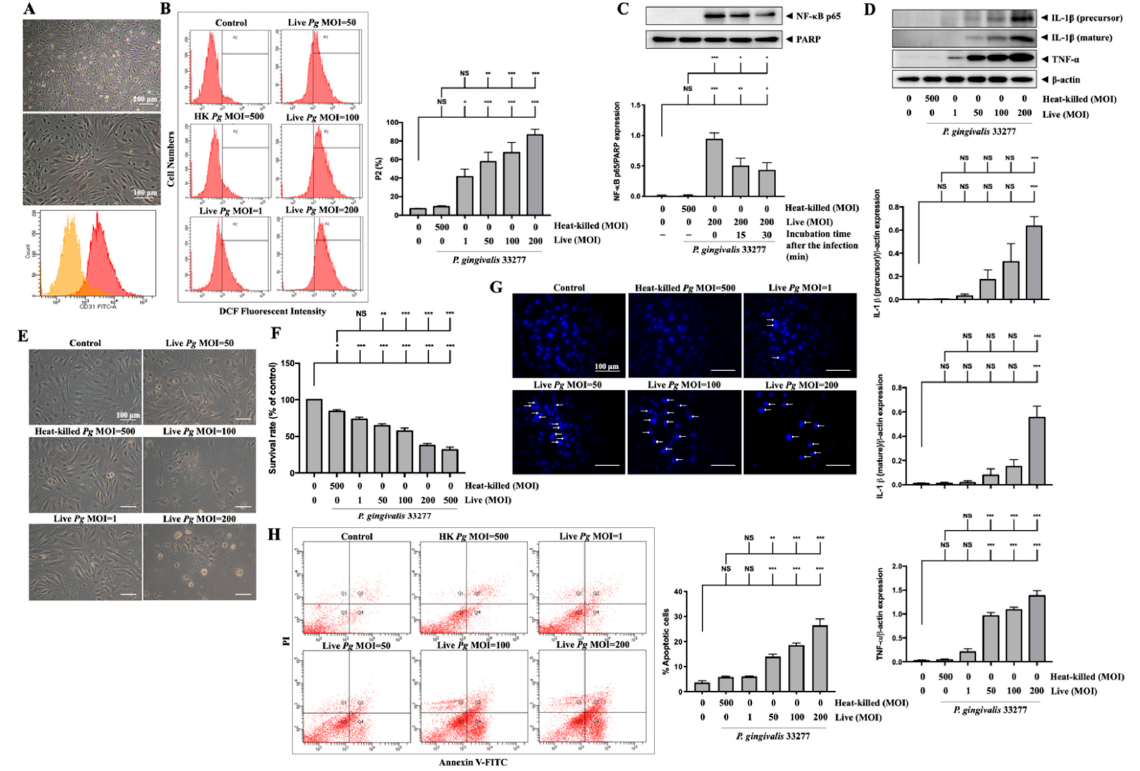
Figure 7. P. gingivalis up-regulates ROS and NF- κ B activation and increases the expression of inflammatory cytokines and cell death in primary mouse brain endothelial cells (MBECs). Cells are obtained from 6–7 weeks of adult C57BL/6 mice. The morphology of MBECs at passage 1 is observed with a light microscope (( A ), upper panel). The expression of platelet endothelial cell adhesion molecule 1 (PECAM-1/CD31) is examined by flow cytometry and presented as histograms (( A ), lower panel). ( B ) MBECs are infected with various MOI (1, 50, 100 and 200) of P. gingivalis for 90 min. The intracellular ROS is determined by DCF fluorescence intensity using flow cytometry shown as gated histogram ( B ). Followed by 24 h of incubation, the expression of IL-1 β (precursor), IL-1 β (mature), TNF- α , and β -actin proteins are determined by Western blot analysis. Quantitative results are presented as bar graphs in low panels ( D ). Cell morphology is observed under a light microscope ( E ). Condensed nuclei are determined by DAPI staining and viewed with a fluorescence microscope. Arrows indicated condensed nuclei ( G ). Annexin V/PI staining is performed to determine apoptotic cells and analyzed by a flow cytometer ( H ). ( C ) Cells are infected with P. gingivalis for 90-min and incubated with fresh medium for the indicated time periods (15 and 30 min), nuclear NF- κ B p65 translocation is determined by Western blot analysis. ( F ) MBECs are infected with various MOI (1, 50, 100, 200 and 500) of P. gingivalis for 90 min. The cell viability is determined by MTT assay (as a percentage of control) after 24 h of incubation. Data are presented as mean values ± SEM ( n = 4). Significant differences of the control group and heat-killed P. gingivalis groups are expressed as *, p < 0.05; **, p < 0.01; ***, p < 0.001; NS, p > 0.05. Scale bars are 200 and 100 μ m in ( A ) and 100 μ m in ( E , G ). 4. Discussion Although some case-control studies and epidemiologic studies reported an increased risk of stroke due to periodontal disease [63], little is known about the underlying mech- anisms. A recent study reported that oral P. gingivalis infection in mice resulted in coloni- zation and increased β -amyloid plaque production in the brain [19]. P. gingivalis infection causes neuroinflammation and cognitive impairment in middle-aged mice [64]. Further- more, gingipain inhibition reduced neuroinflammation and rescued neurons in the hip- pocampus in the bacterial load of a P. gingivalis brain infection model [19]. Importantly, periodontitis is associated with an increase in cognitive decline in AD that has been at- tributed to systemic inflammation [5]. An oral gingipain inhibitor is now being tested in